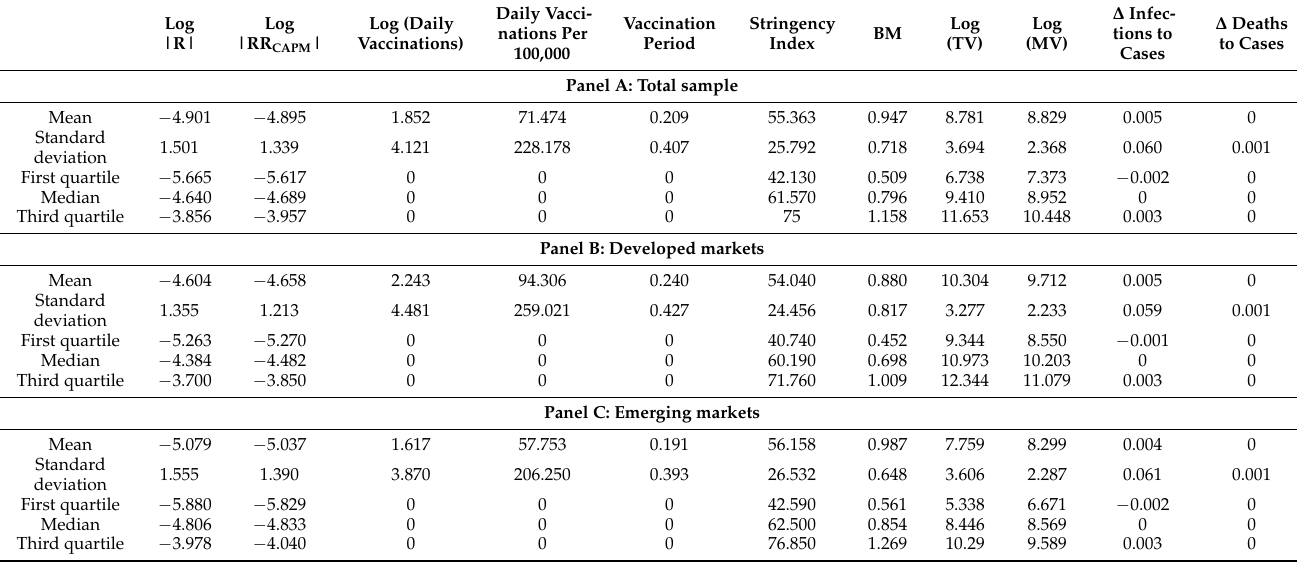
Table 2. Statistical properties of major variables.